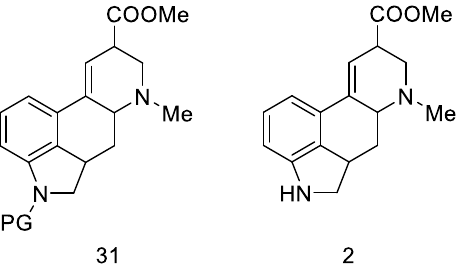
Figure 11. Woodward intermediate 31 and deprotected compound 2 .